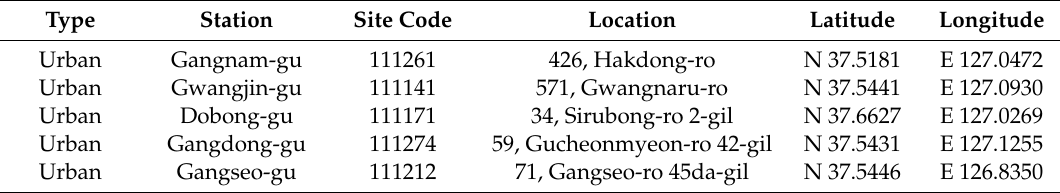
Figure 1. Distribution of monitoring stations in Seoul. Table 1. Selected monitoring stations in Seoul.